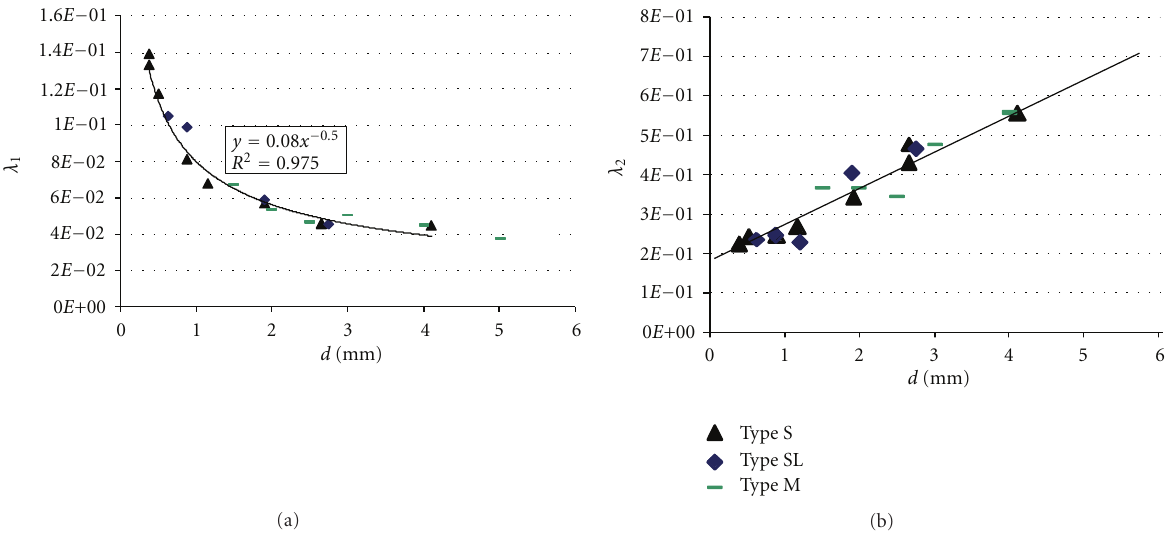
Figure 5: Representation of the λ 1 (a) and λ 2 (b) evolutions versus bead diameters for the 3 types of glass beads S, SL, and M.